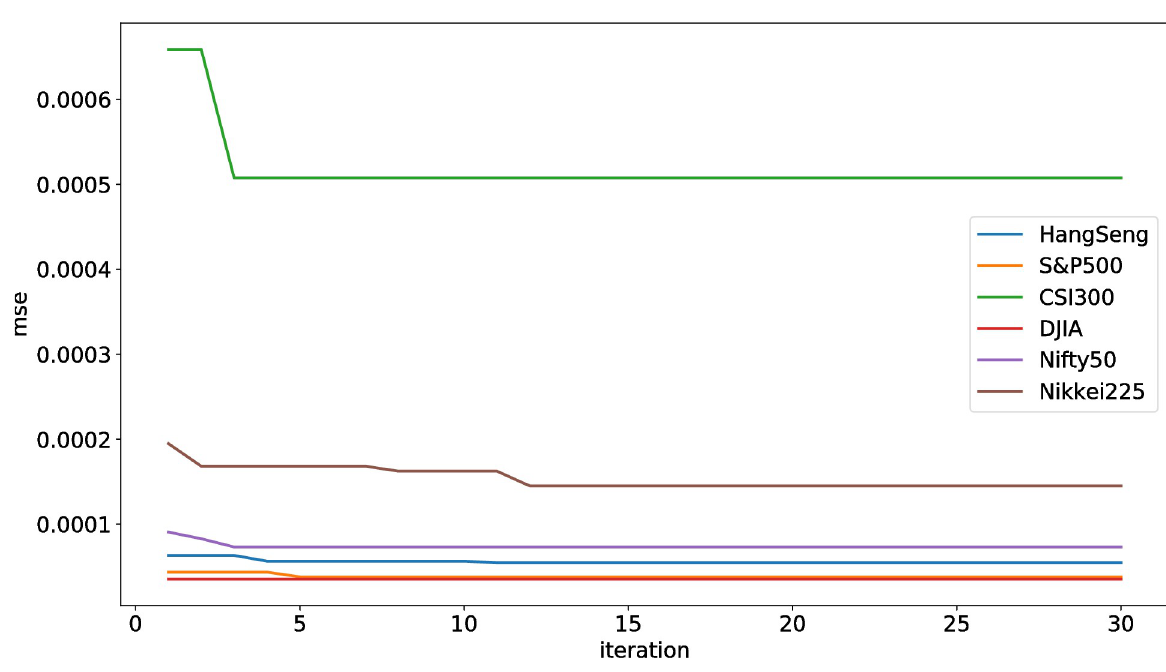
Fig 11. Convergence diagram of six stock indexes. https://doi.org/10.1371/journal.pone.0272637.g011 4.2.3 Convergence comparison between AGA-LSTM and GA-LSTM. As shown in Fig 10, AGA-LSTM, and GA-LSTM can quickly determine the approximate optimal solution in the search space. Compared with GA, the convergence effect of AGA shows little difference in the early and middle stages, but the convergence speed of AGA suddenly accelerates in the later stage. The results verify that the adaptive strategy proposed in this study improves the crossover and mutation rates of the algorithm in the later stages of evolution. This new optimi- zation mode drives individuals to continuously evolve and helps the algorithm eliminate the old model and jump out of the local optimization.